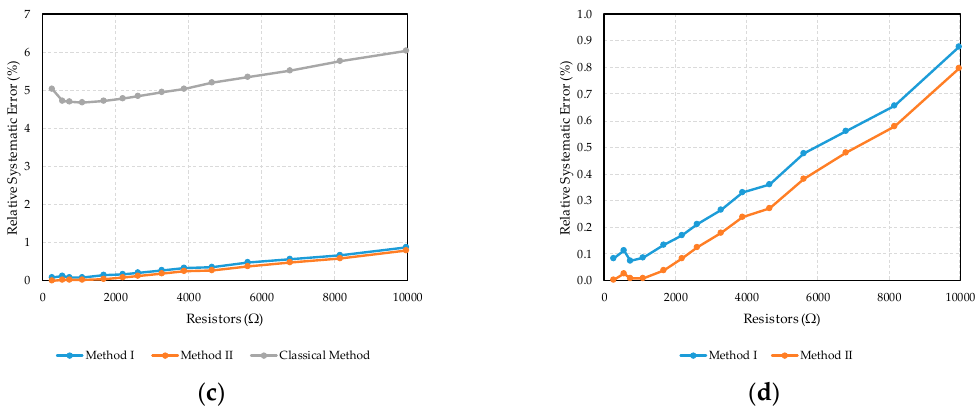
Figure 9. ( a ) Relative systematic error for Experiment 1; ( b ) Further detail of Method I and II relative systematic error for Experiment 1; ( c ) Relative systematic error for Experiment 2; ( d ) Further detail of Method I and II relative systematic error for Experiment 2.